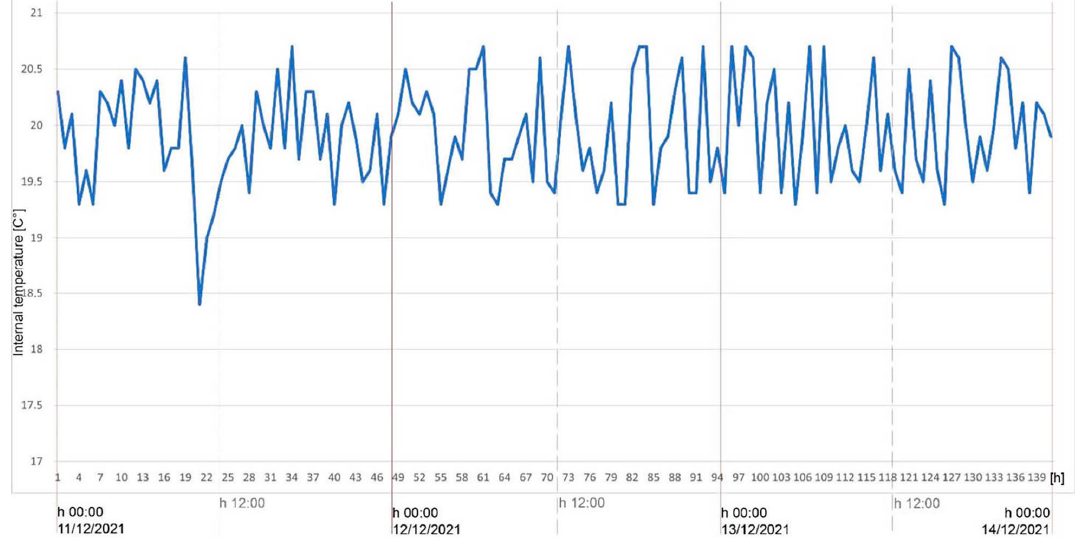
Figure 12. Internal temperature diagram as a function of time: ante operam.